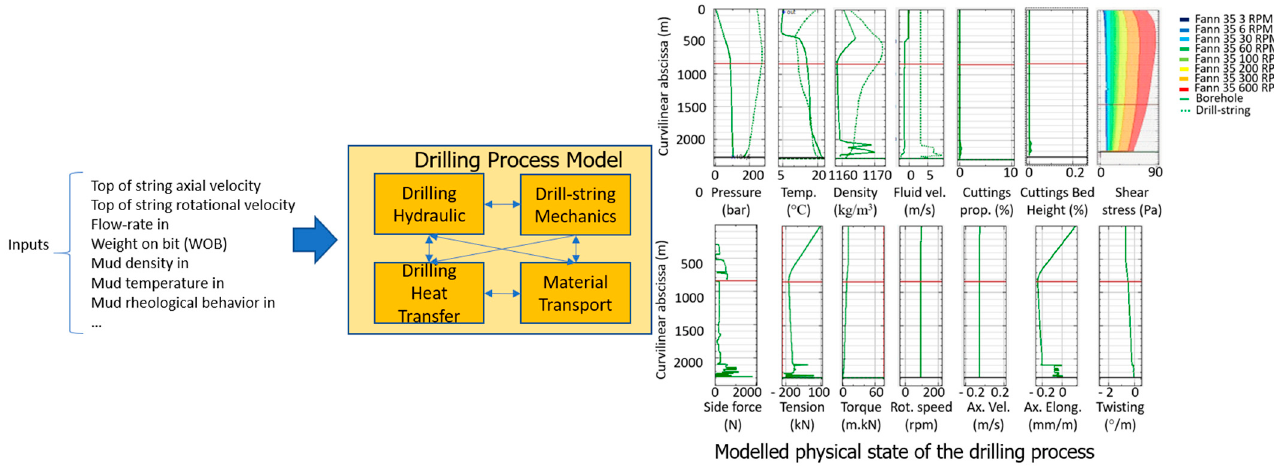
Figure 1. Schematic representation of the modelling of the physical state of the drilling process (modified version of Figure 146 in [23]).